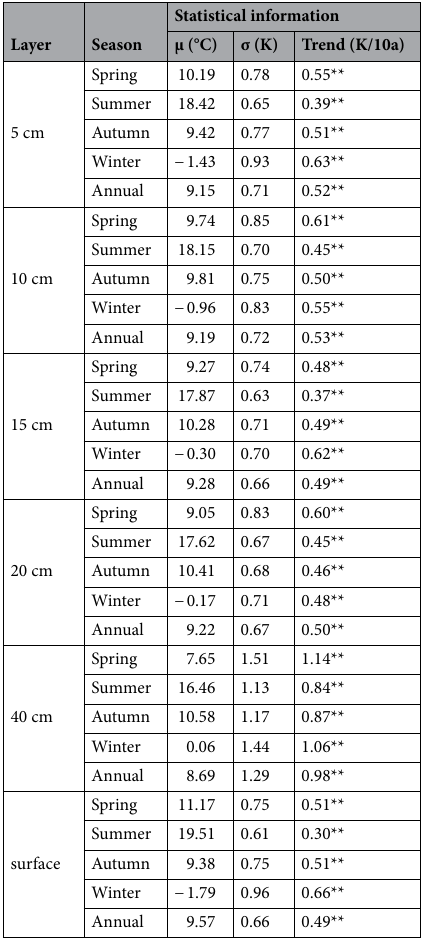
Table 1. Statistical information on the annual average and interannual variations in various seasons on the Qinghai-Tibet Plateau from 1981 to 2020. μ mean, σ standard deviation. **Denotes trends statistically significant at α =